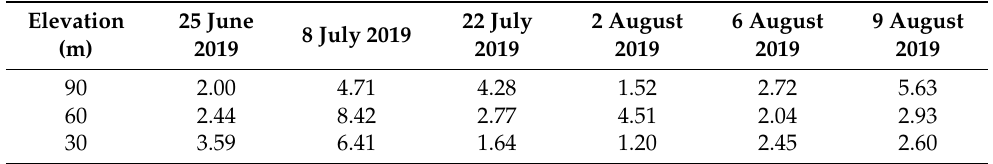
Figure A1. Thermal ground reference data vs. surface temperature values remotely collected with Micasense Altum. Ground reference data were collected within half an hour of mission launch. Table A1. Root Mean Square Error (RMSE) of thermal ground reference data vs. surface temperature ( ◦ C) values collected with Micasense Altum. Ground reference data were collected within half an hour of mission launch.